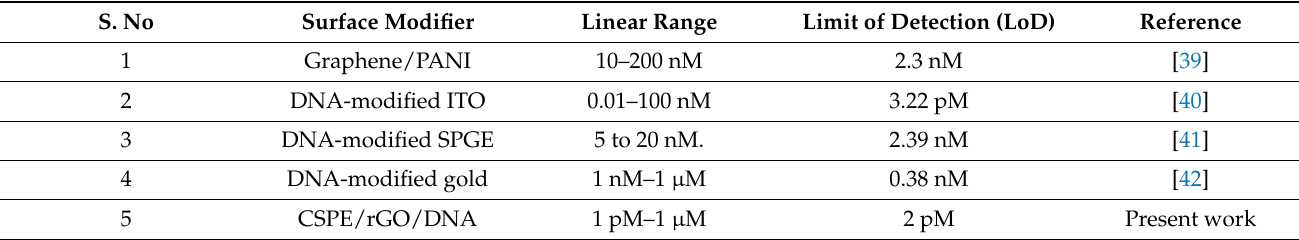
Table 1. Comparison of sensing parameters of the developed HPV-16 biosensor with few reported ones. (PANI: polyaniline; ITO: indium tin oxide; SPGE: screen-printed gold electrode; CSPE: carbon screen-printed electrodes, rGO: reduced graphene oxide).